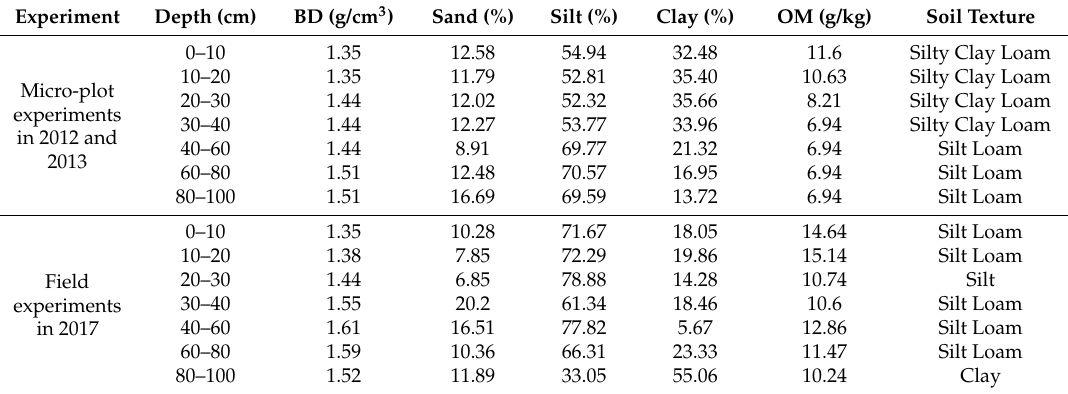
Table 3. Soil physical properties of micro-plots (mean value of the 14 micro-plots) and fields (mean value of the 7 micro-plots).